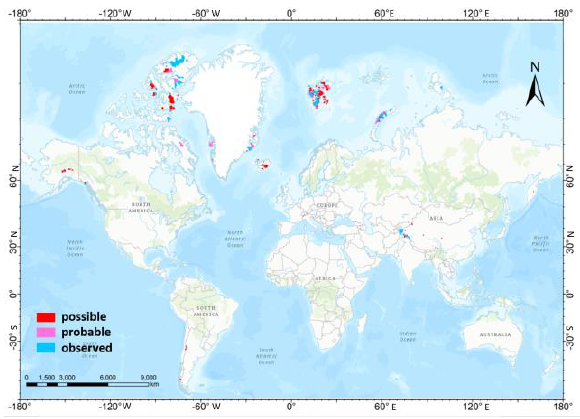
Figure 1 . Global distribution of surge-type glaciers based on Randolph Glacier Inventory (RGI) version